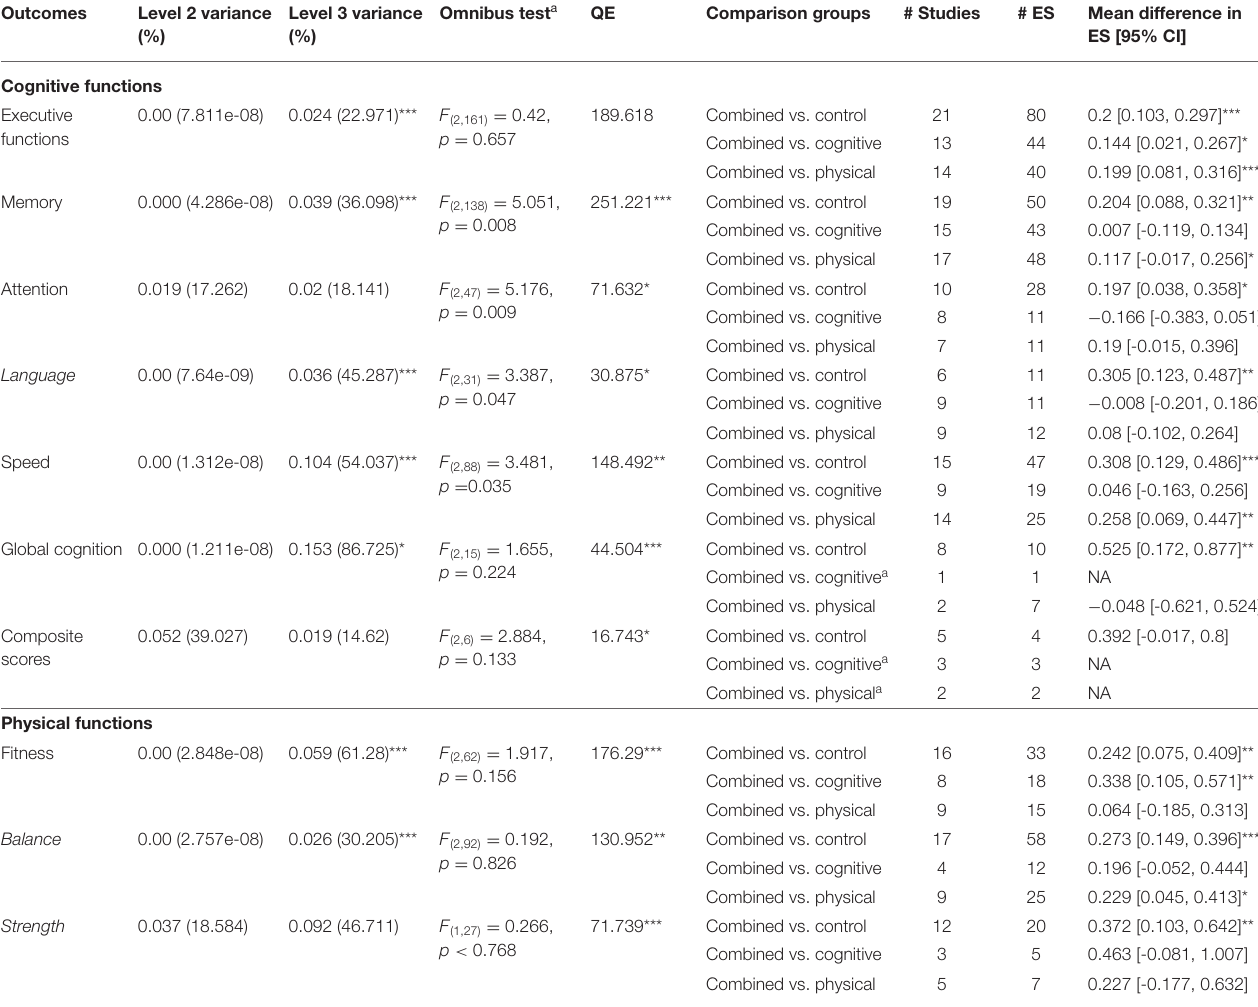
TABLE 3 | Results of moderator analyses for pre-post comparisons between combined training vs. control, cognitive or physical single for cognitive and physical outcomes.